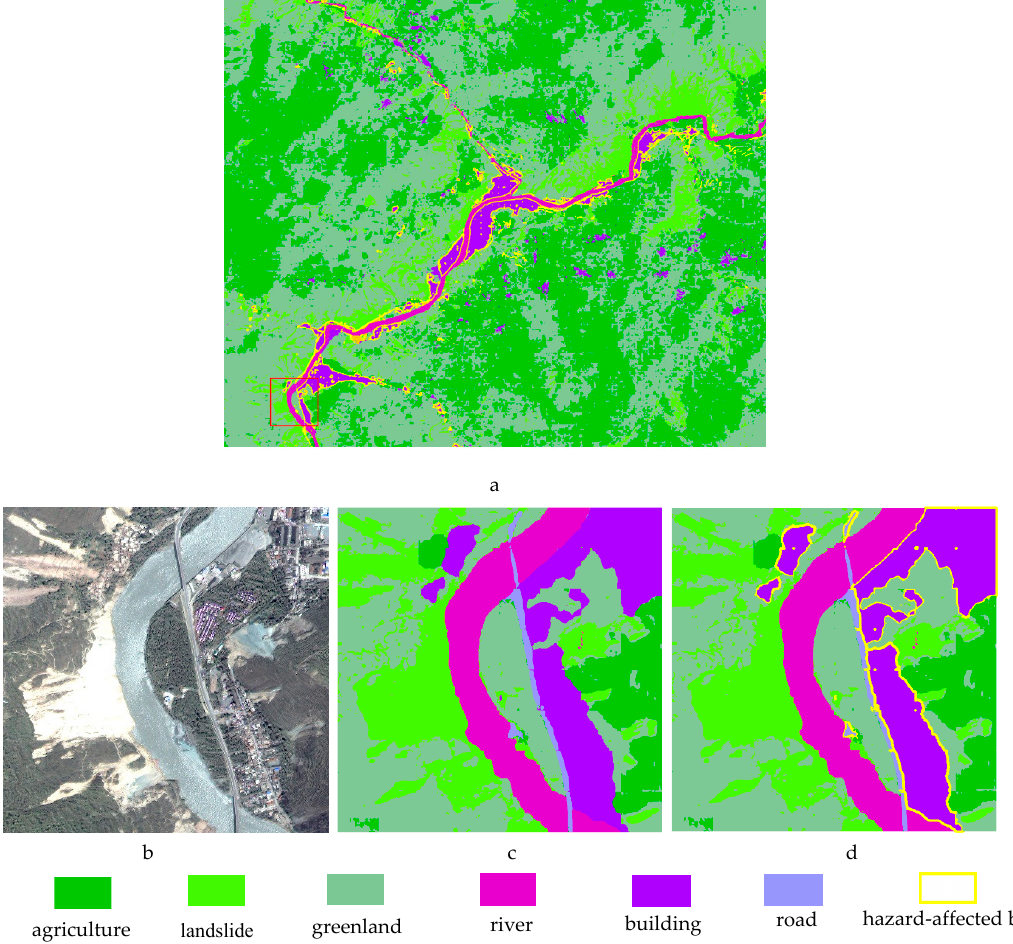
Figure 20. The result of our method: ( a ) semantic segmentation map of the entire research area; ( b ) remote sensing image corresponding to the part in the red box in (a); ( c ) corresponding semantic segmentation map of ( b ); ( d ) hazard-a ff ected body map (with yellow boundary) of ( b